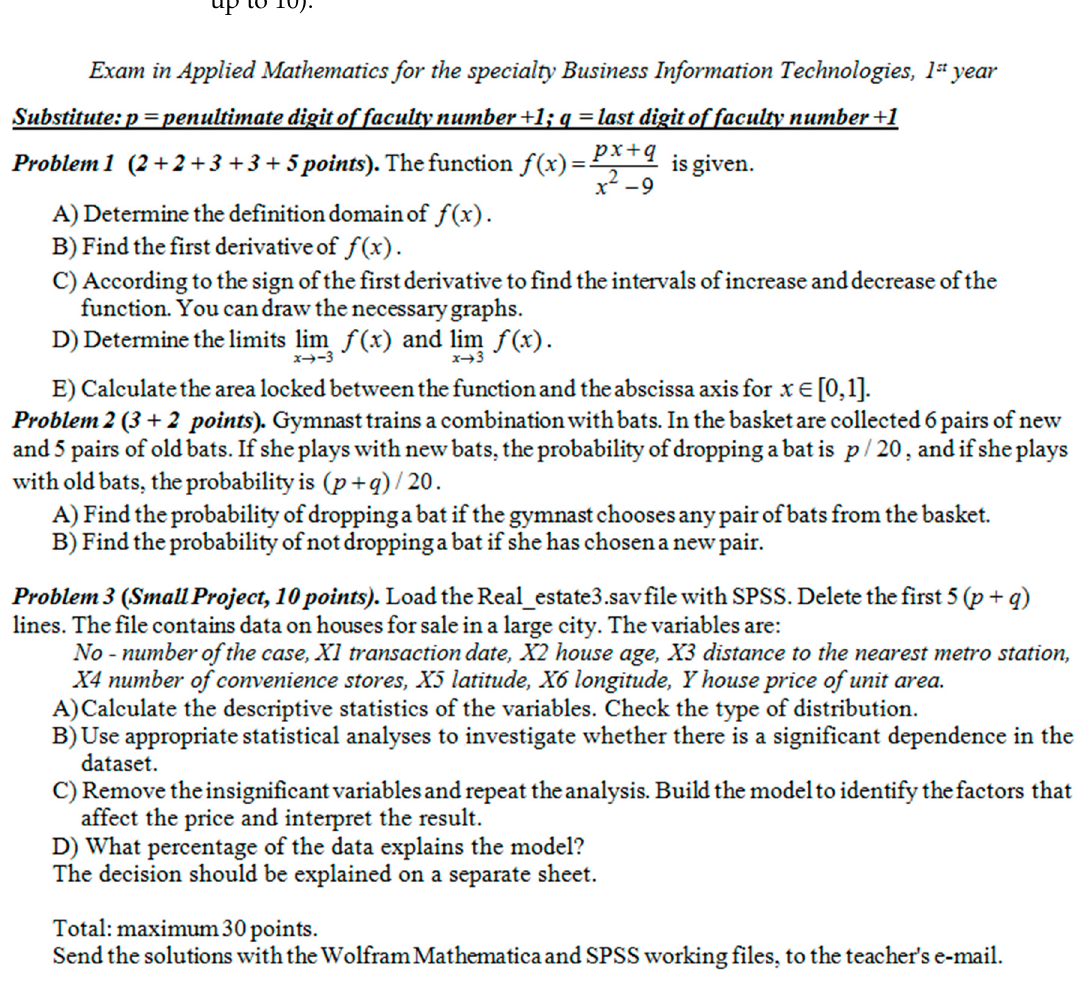
Figure 1. Example of the exam test in Applied Mathematics.